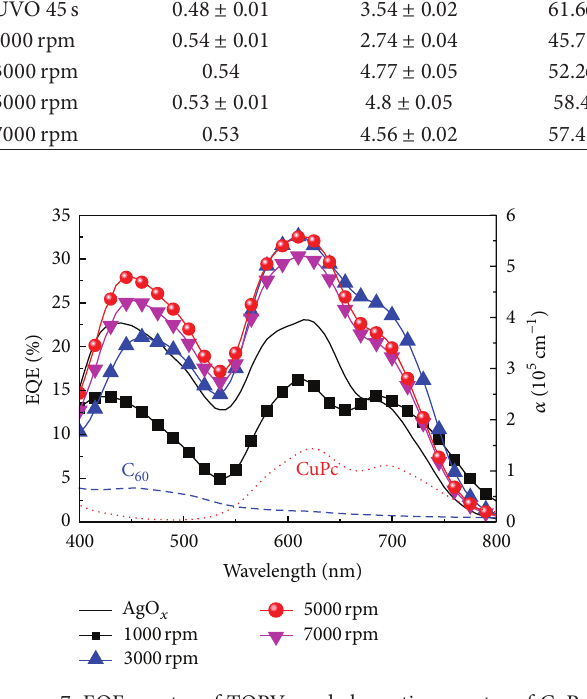
Figure 7: EQE spectra of TOPVs and absorption spectra of CuPc and C 60